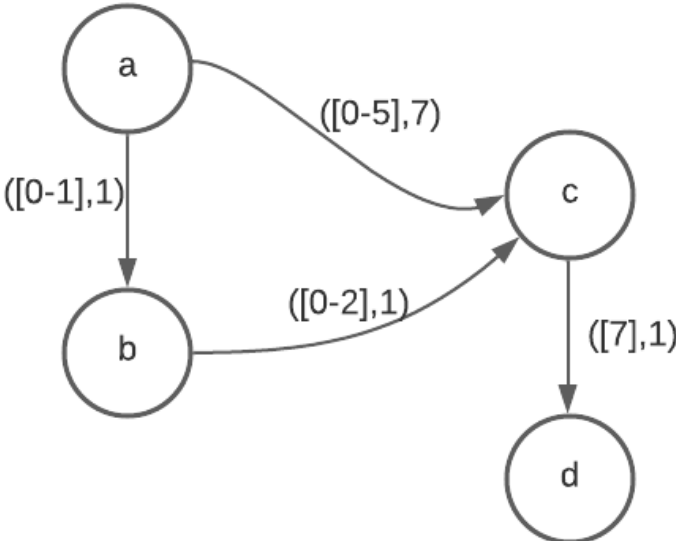
Figure 3. Example of mhf paths from source vertex a .